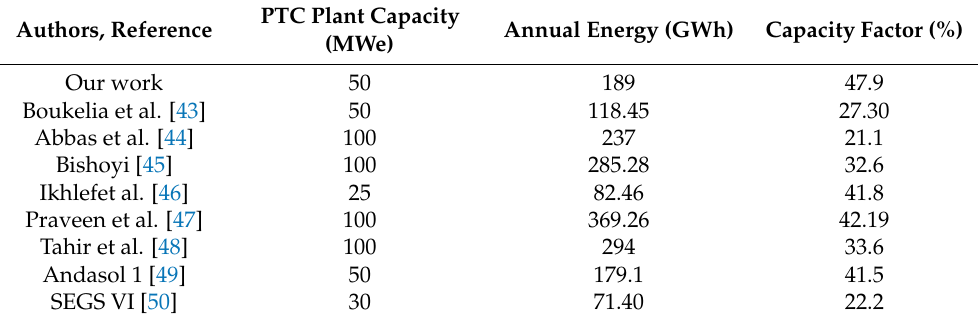
Table 6. Comparison with previously published